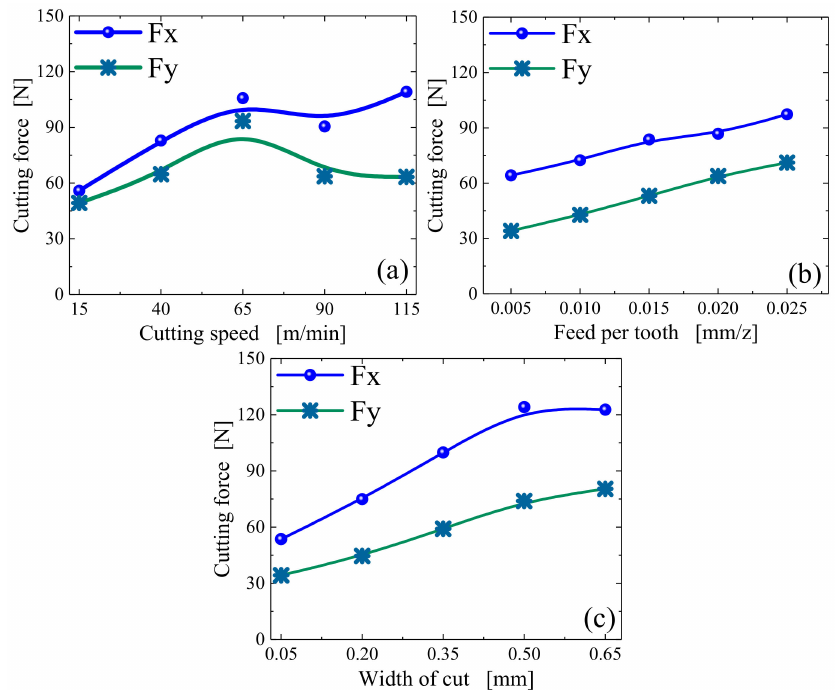
Figure 16. Response relationships between cutting force and milling parameters. ( a ) Under di ff erent cutting speed; ( b ) Under di ff erent feed per tooth; ( c ) Under di ff erent width of